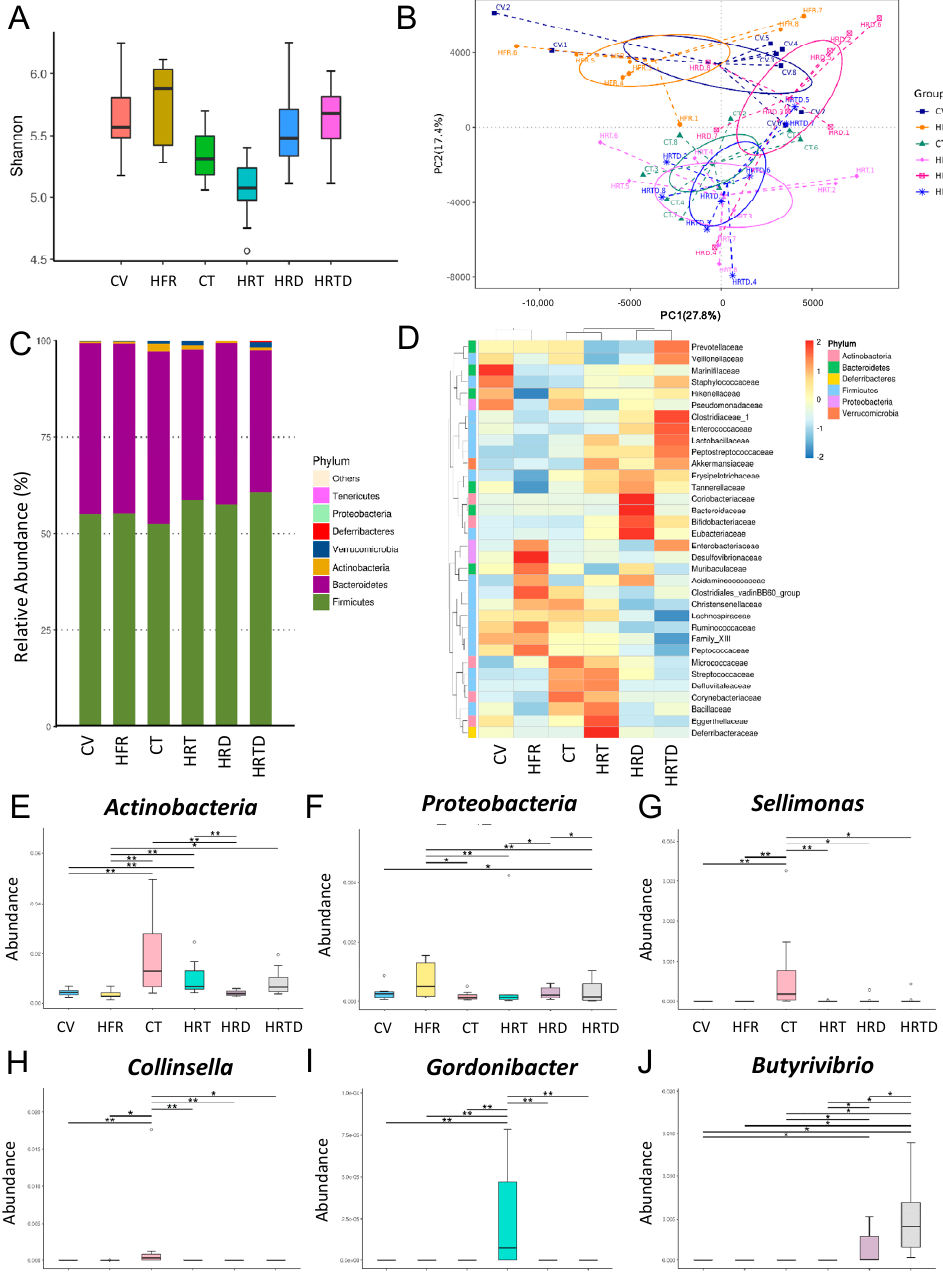
Figure 5. Effects of high-fructose intake, 2,3,7,8-tetrachlorodibenzo-p-dioxin (TCDD) exposure, and 3,3-Dimethyl-1-butanol (DMB) on the gut microbiota in offspring at 12 weeks of age. ( A ) α -diversity was represented by the Shannon’s indexes. ( B ) β -diversity changes in gut microbiota across groups were shown by principal component analysis (PCA). ( C ) Relative abundance of the top 10 phyla of the gut microbiota among the six groups. ( D ) Heat map of the 16S rRNA gene sequencing analysis of the gut microbiome at the family level. The abundance of ( E ) phylum Actinobacteria , ( F ) phylum Proteobacteria , ( G ) genus Sellimonas , ( H ) genus Collinsella, ( I ) genus Gordonibacter , and ( J ) genus Butyrivibrio among the six groups. CV = control rats received regular diet and vehicle; HFR = rats received high-fructose diet; CT = rats received regular diet and TCDD exposure; HRT = rats received high-fructose diet and TCDD exposure; HRD = rats received high-fructose diet and DMB treatment; HRDT = rats received high-fructose diet, TCDD exposure, and DMB treatment. * p < 0.05. ** p <